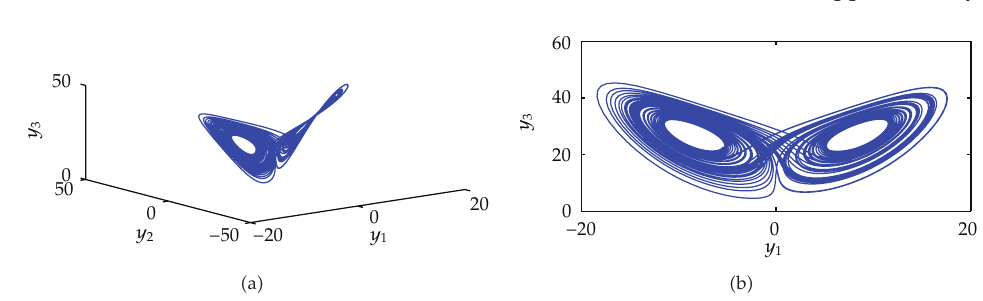
Figure 1: Chaotic attractors of the fractional-order Lorenz system (cid:2) 3.1 (cid:3) for q r (cid:8) 0 . 995.